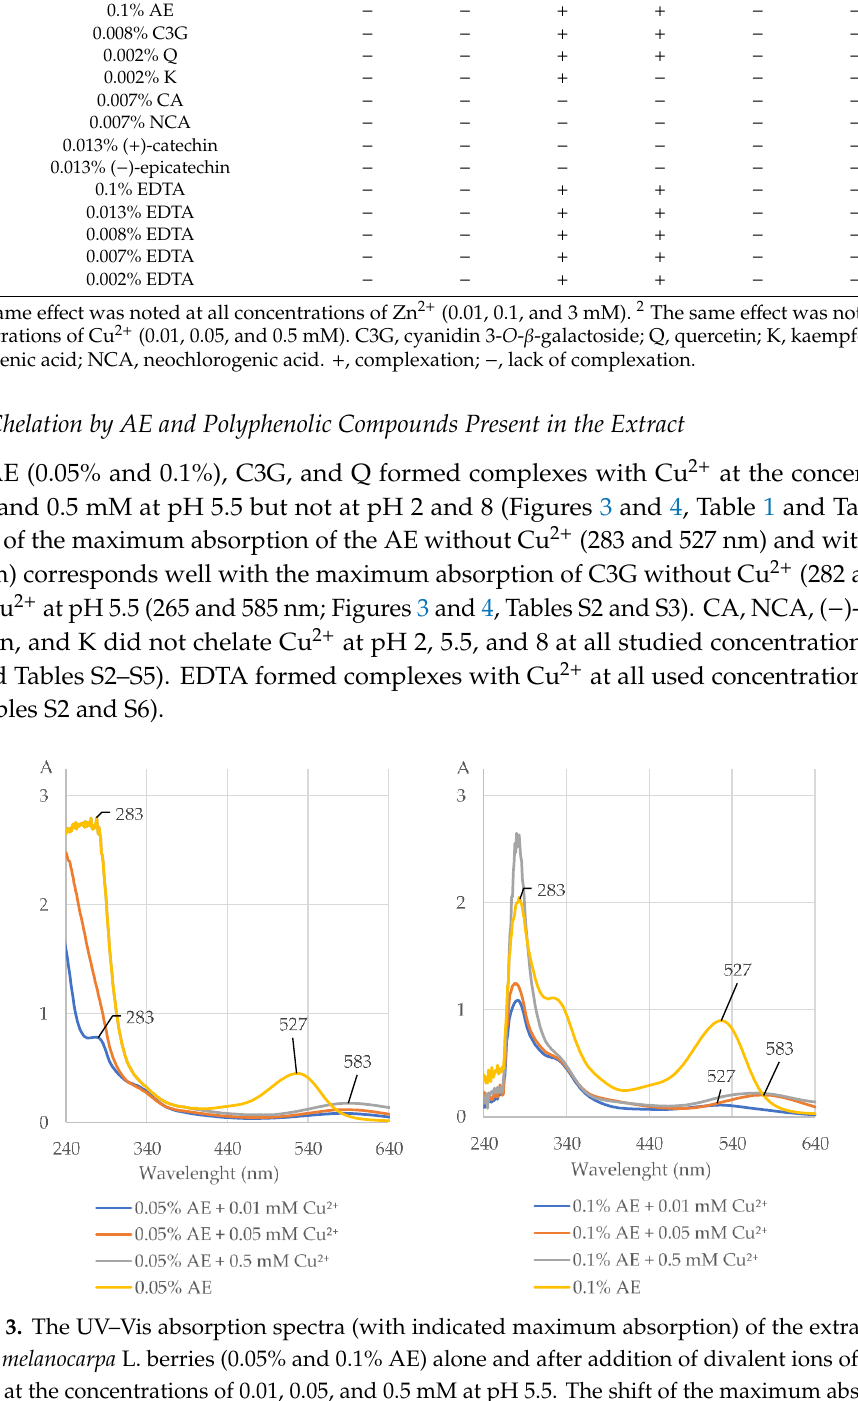
Table 1. Summarizing the results of the evaluation of complexation of divalent ions of zinc (Zn 2 + ) at the concentrations of 0.01, 0.1, and 3 mM and copper (Cu 2 + ) at the concentrations of 0.01, 0.05, and 0.5 mM by 0.1% extract from Aronia melanocarpa L. berries (AE) and the main polyphenolic compounds present in the extract, as well as by ethylenediaminetetraacetic acid (EDTA). 1, 2. pH 2 pH 5.5 AE, Polyphenolic Compound or EDTA